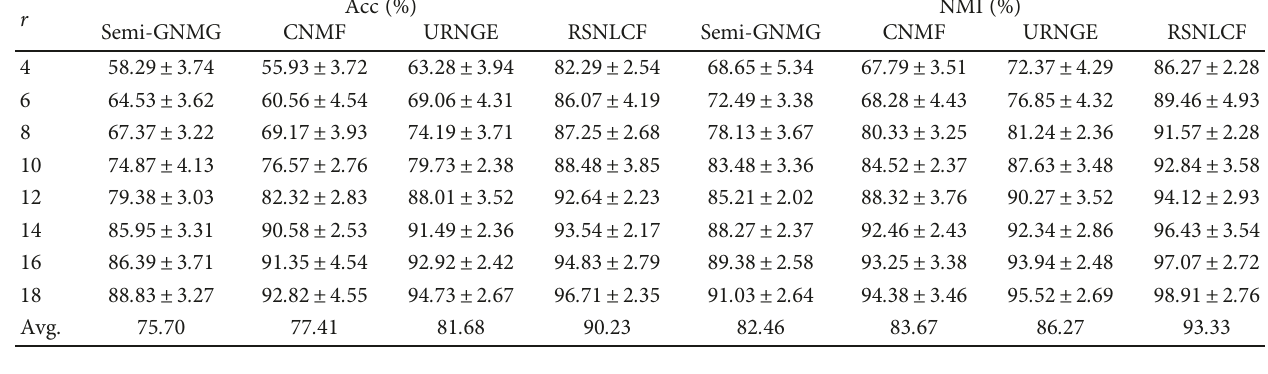
Table 2: Clustering performances on the AR dataset.